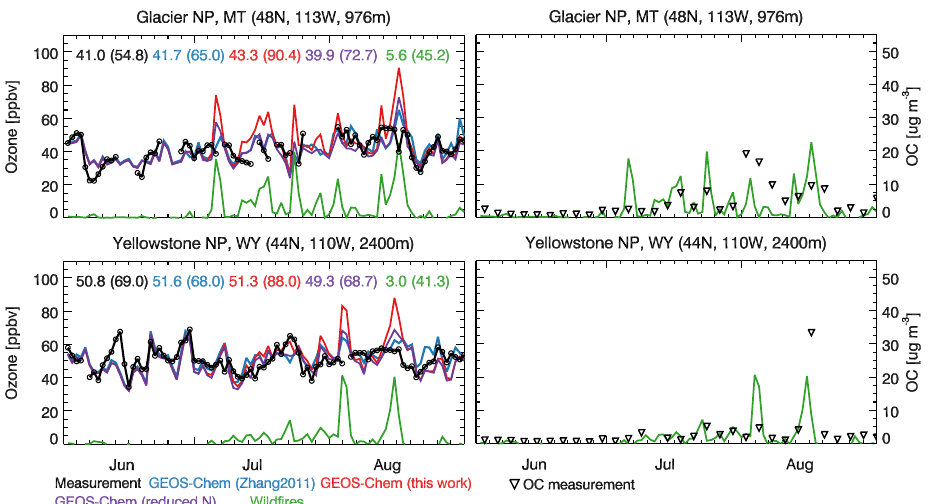
Figure 8. Time series of MDA8 ozone concentrations at the Glacier NP, Montana, and Yellowstone NP, Wyoming, CASTNet sites in summer 2007. Observations (black line) are compared to model results from Zhang et al. (2011) (blue line), model results from this work including daily emissions based on fire reports (red line), and further with reduced emission factor for NO x (purple line). Also shown are simulated wildfire ozone enhancements as computed by the difference between the improved simulation and a sensitivity simulation with wildfire emissions turned off (green line). The mean (maximum) concentrations for the time period are shown inset. Inverted triangles in the right panels are organic carbon (OC) particulate matter concentrations observed at collocated IMPROVE sites.